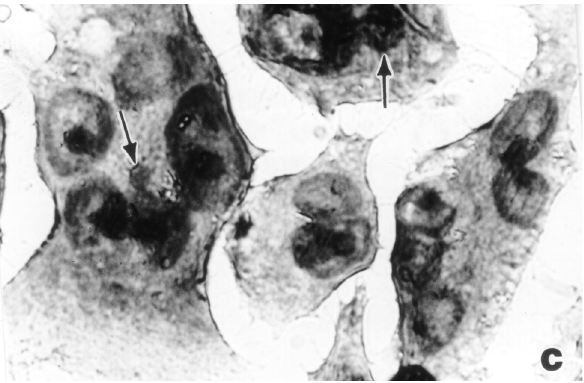
Figure 2: Morphological characteristics of untreated and tamox- ifen treated HeLa cells under the light microscope. (a) Confluent control cells at 72 hours showing normal morphology with lamel- lipodium, prominent nucleus, and nucleoli in each cell × 400. (b) Tamoxifen treated cells (10 µ g/ml) at 48 hours showing nuclear con- densation, cell shrinkage, and enucleation (arrow) × 400. (c) Cells treated with tamoxifen (15 µ g/ml) at 48 hours showing multinucle- ation and apoptotic bodies (arrows) ×